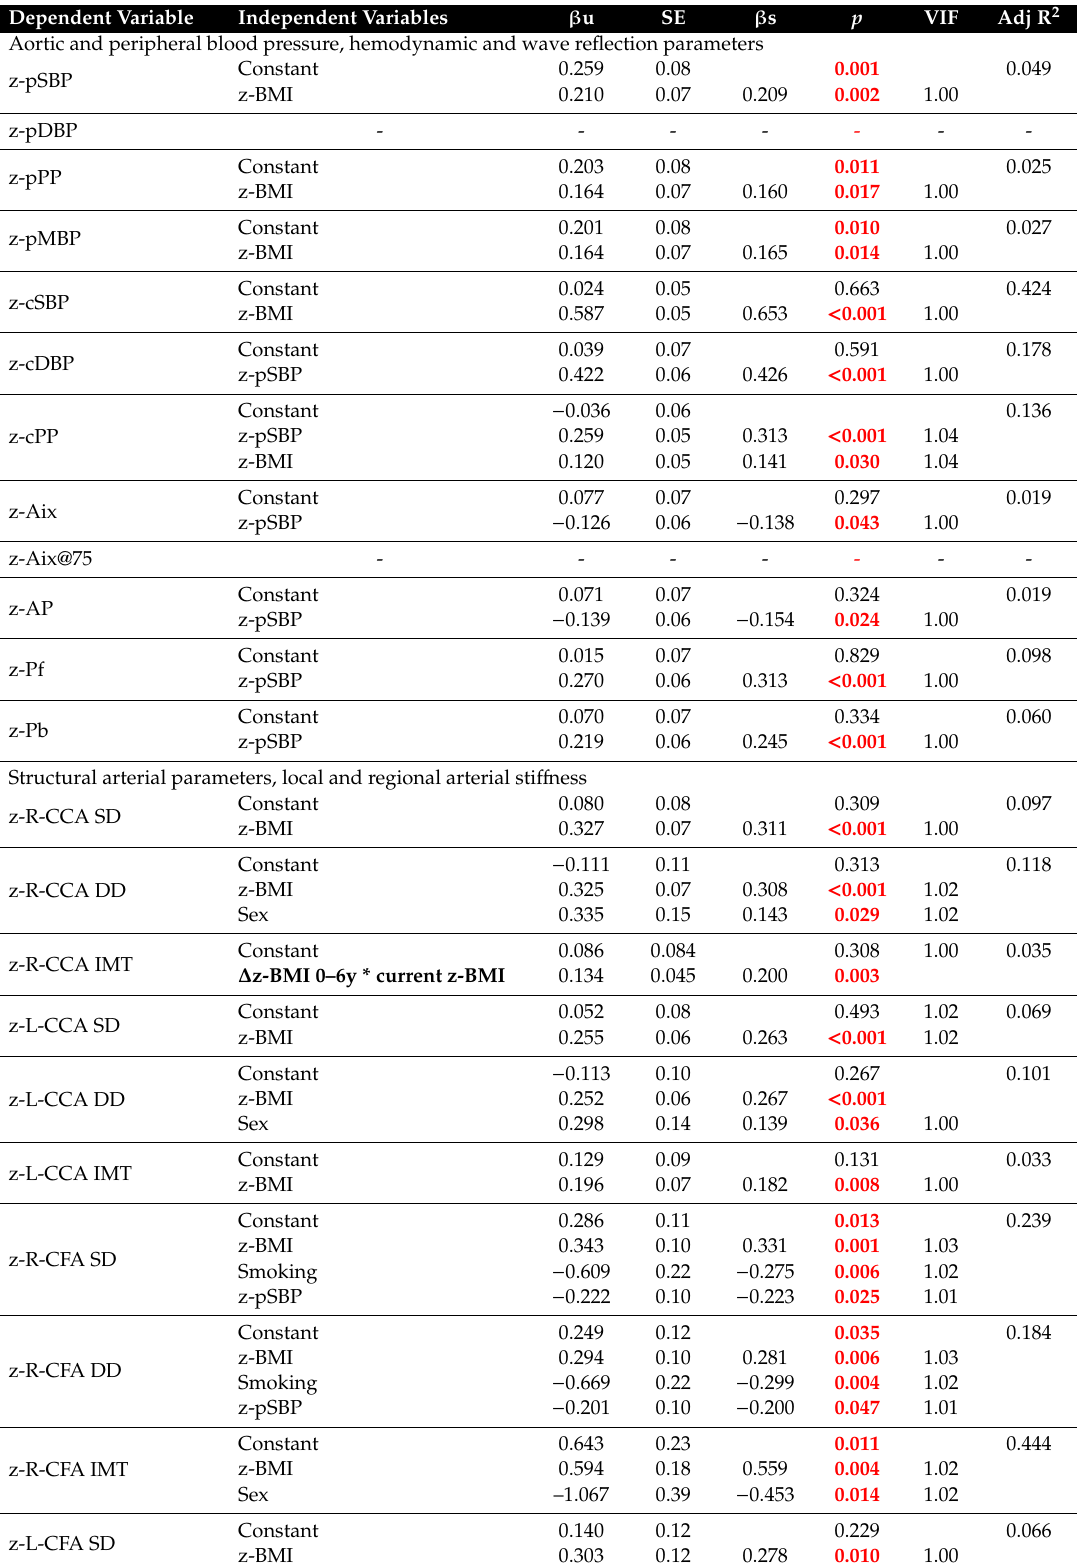
Table 10. Multiple regression analysis between CVvariables (dependent) and anthropometric and CRFsvariables (independent) in adolescent cohort ( n =